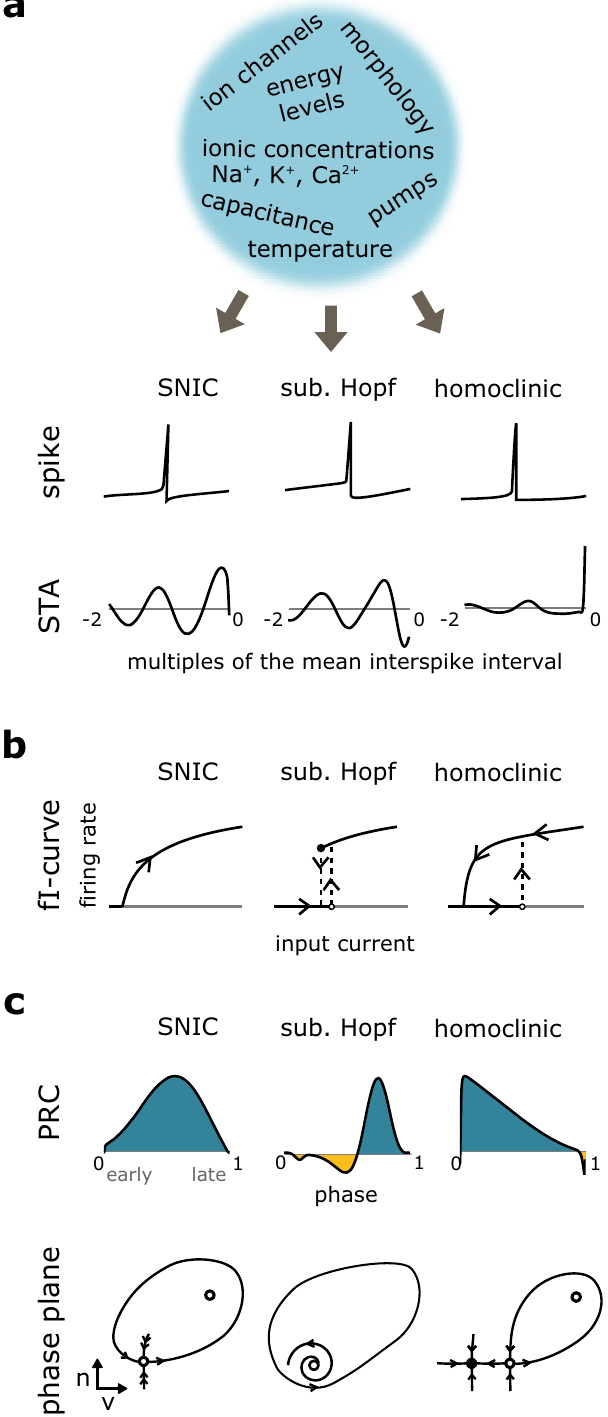
Fig. 1 Action-potential dynamics of regularly fi ring cells come in three mathematical types with different spike onset bifurcations, saddle node on invariant cycle (SNIC), saddle-homoclinic orbit (HOM), and subcritical Hopf bifurcation. a Biophysical properties set the spike onset dynamics, including the spike-triggered averages (STAs) close to the threshold. b The three spike onset dynamics differ in their fi ring-rate-input curves (f – I curves), c typical phase-response curves (PRCs, top), and phase planes (bottom); closed circles denote stable fi xed points, open circles unstable fi xed points, and half- fi lled circles a saddle node. Arrows indicate the direction of the